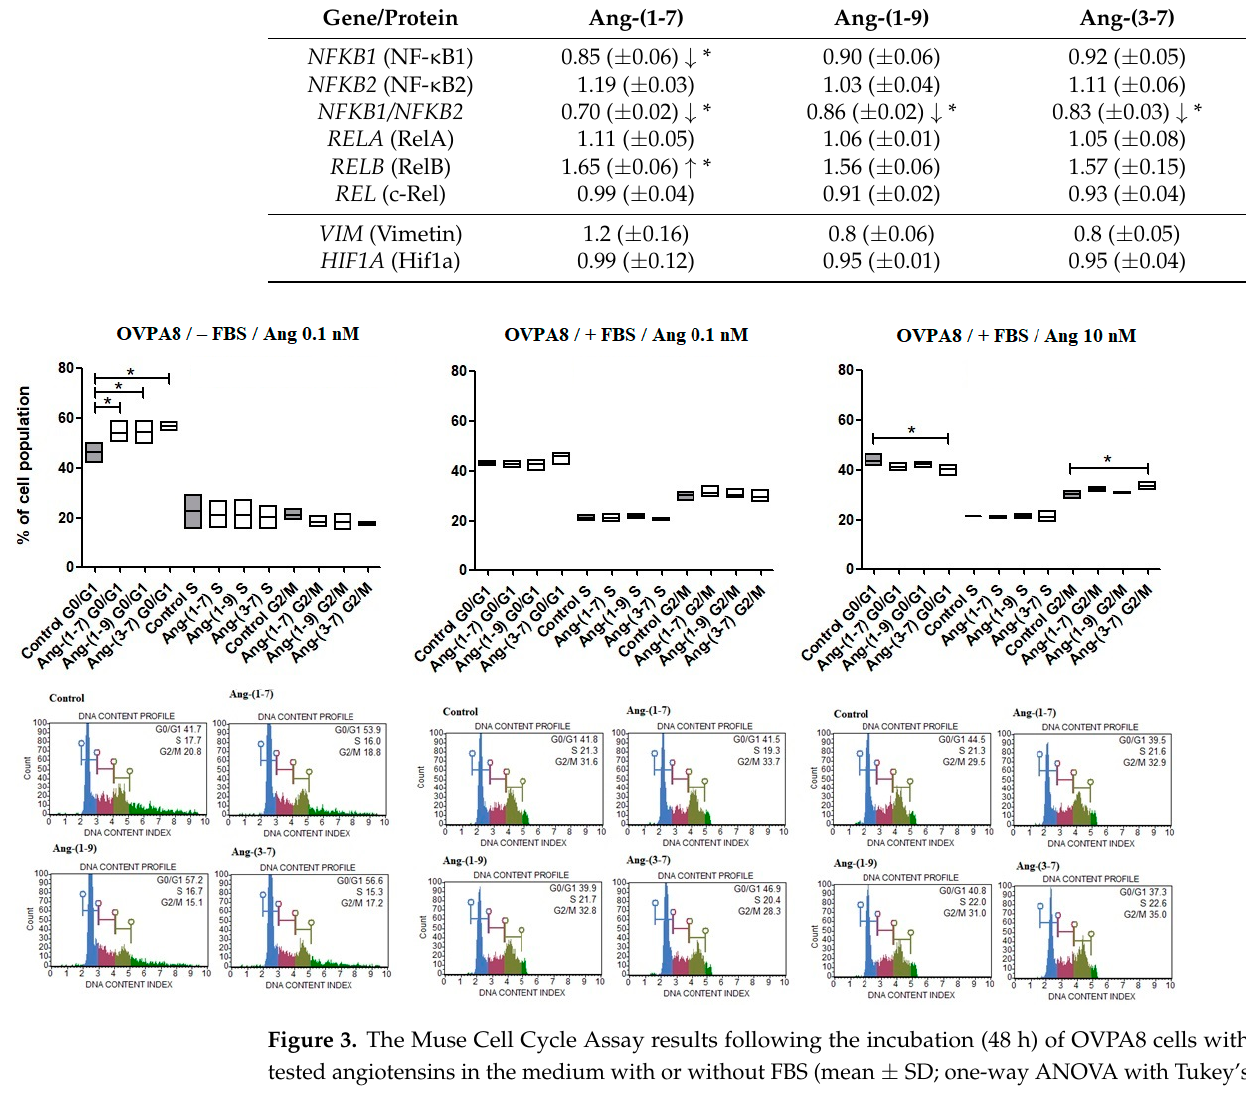
Figure 3. The Muse Cell Cycle Assay results following the incubation (48 h) of OVPA8 cells with tested angiotensins in the medium with or without FBS (mean ± SD; one-way ANOVA with Tukey’s test: * p < 0.05).